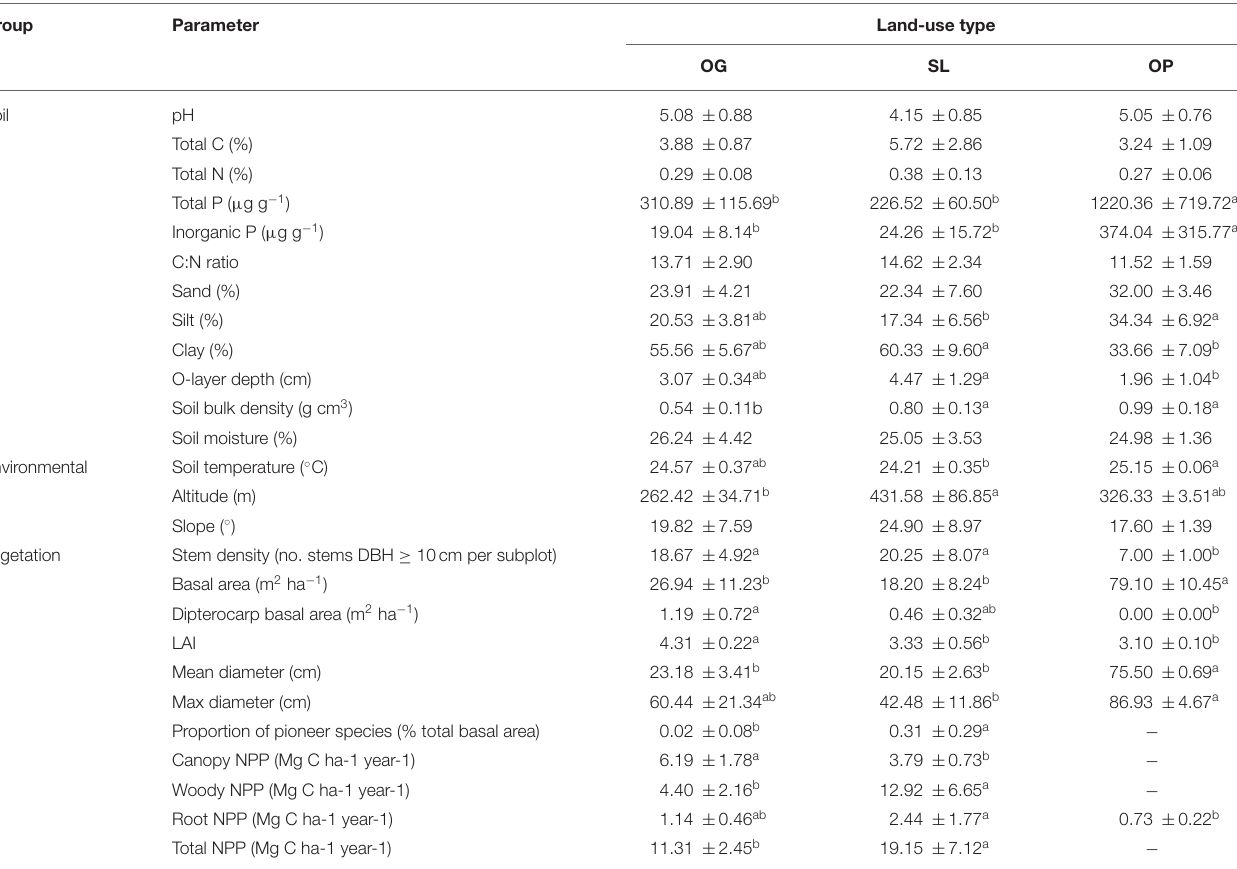
TABLE 2 | Means ( ± 1 SD) of soil, environmental, and vegetation characteristics by land-use type for old-growth (OG) and selectively logged (SL) lowland dipterocarp rainforest and oil palm plantation (OP) in Sabah, Borneo. Group